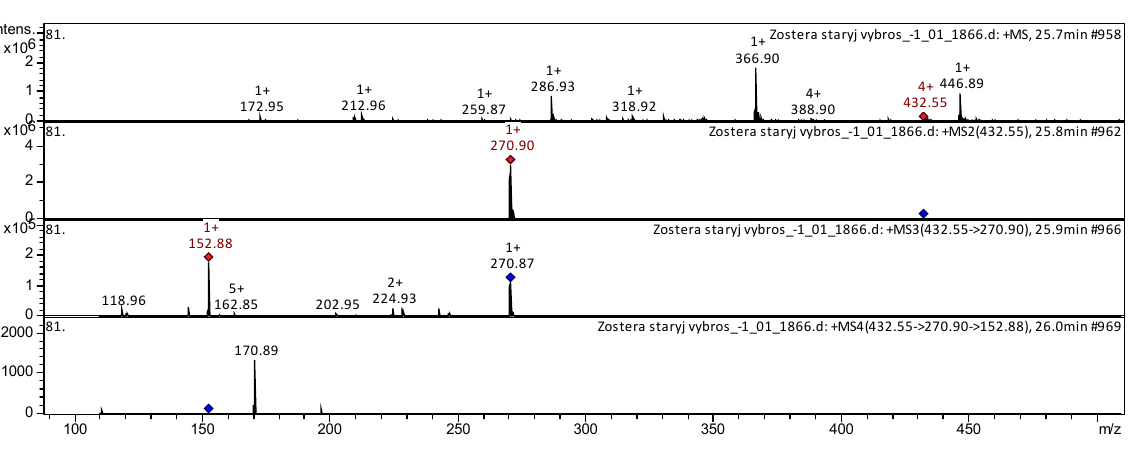
Figure 7. CID spectrum of Apigenin 7–sulfate from Z. marina , m/z 348.95.